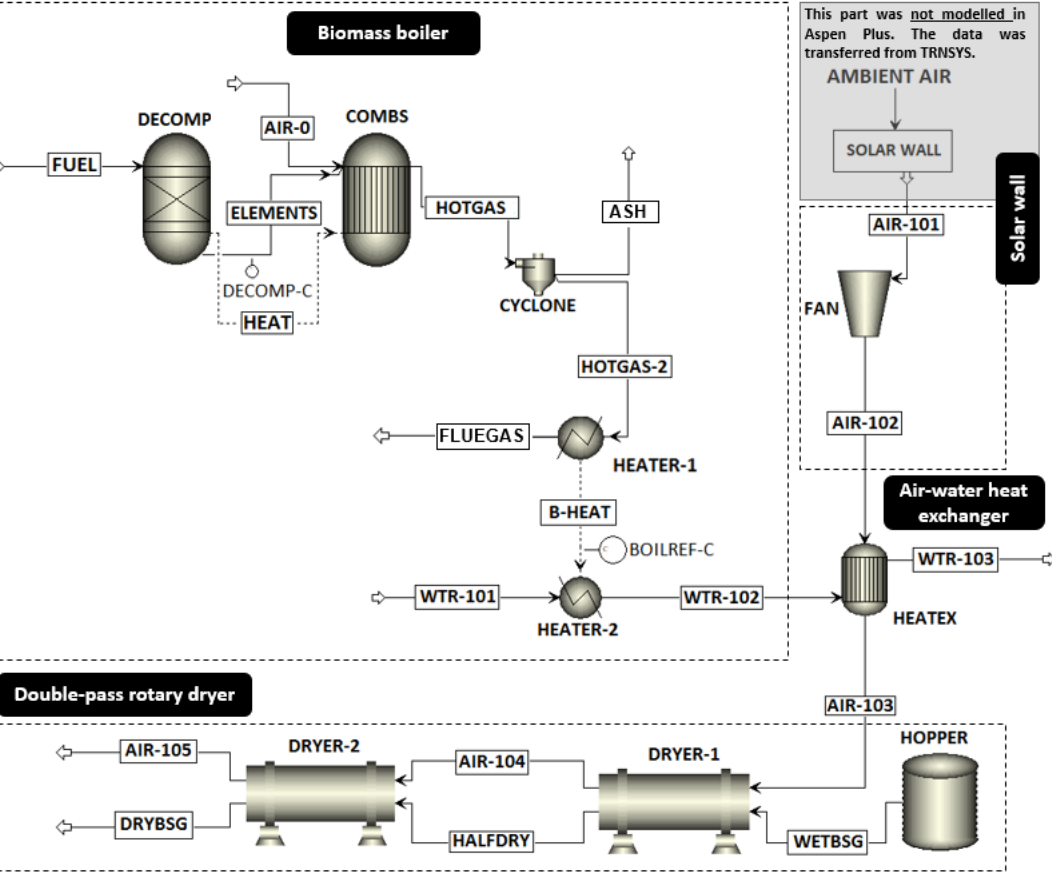
Figure 1. Aspen Plus process flowsheet of the low-temperature drying process. The areas indicated within dashed lines show the parts, which were modeled in Aspen Plus.